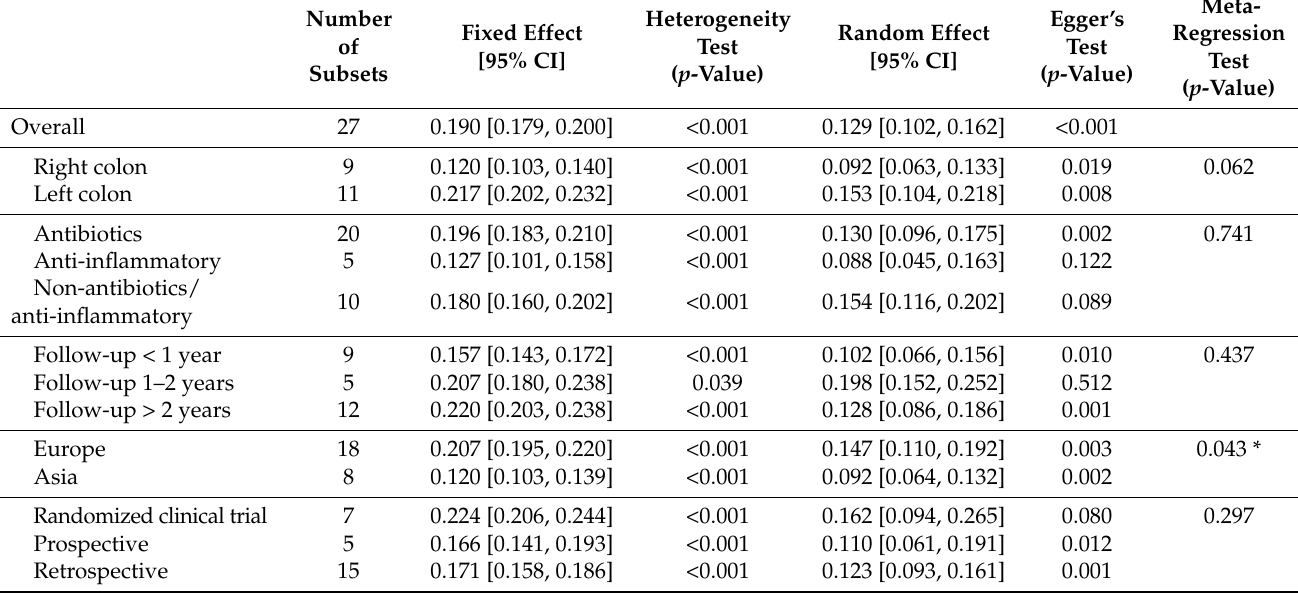
Table 2. The estimated recurrence rate of uncomplicated diverticulitis.